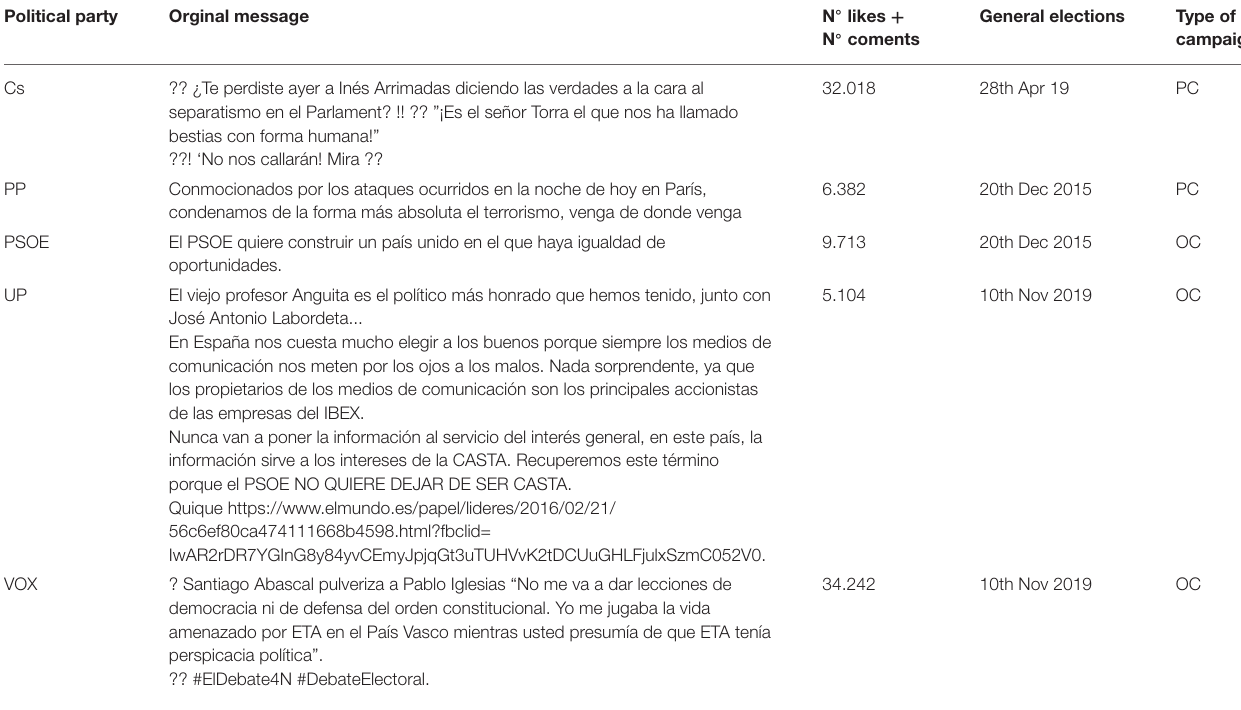
TABLE 6 | Original messages from each political party that have had the most number of likes and comments. Political party